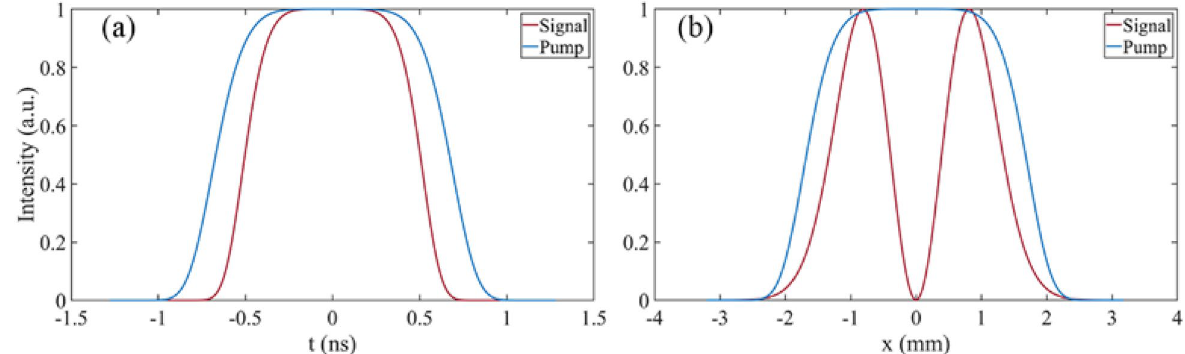
Figure 1. ( a ) Temporal profile and ( b ) spatial beam profile of input signal (red line) and pump (blue line) beam.